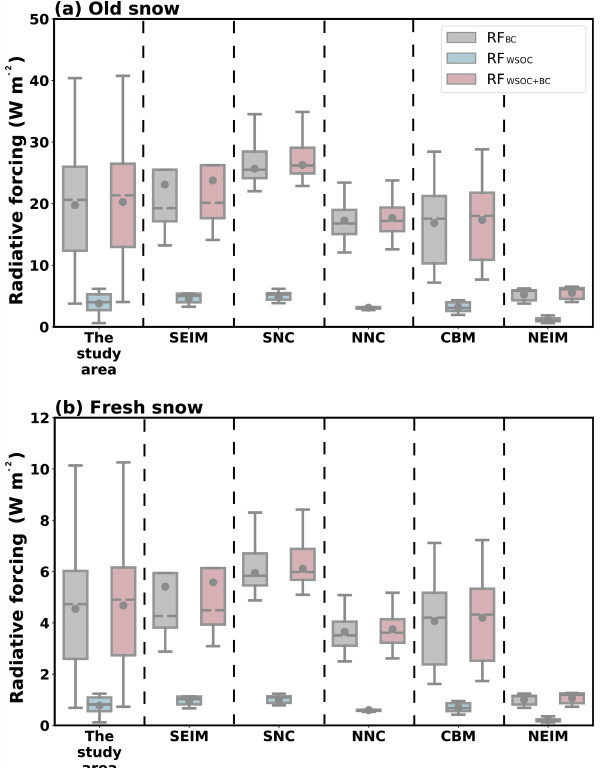
Figure 9. Radiative forcing due to different pollutants in (a) old or (b) fresh snow. Gray, blue, and red indicate the radiative forcing of BC, WSOC, and BC + WSOC,